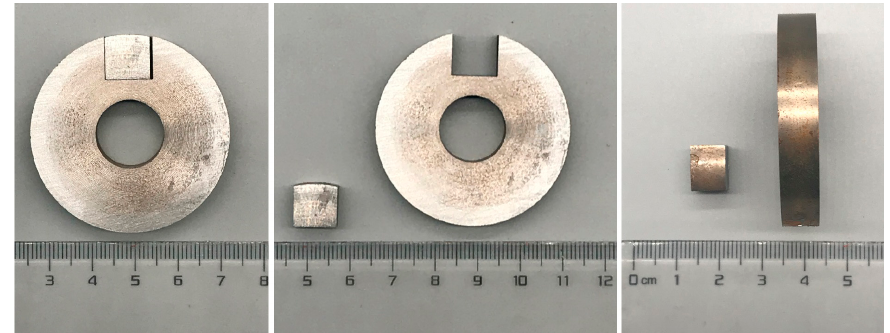
Figure 1. Photographs of samples and the cutting after rolling.